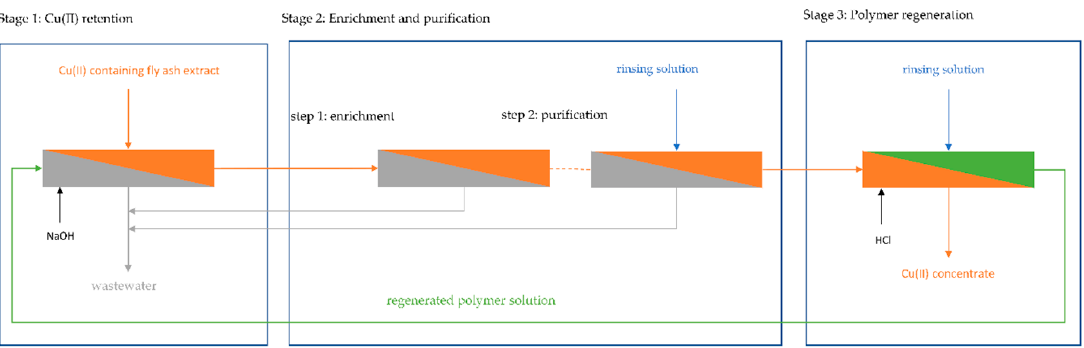
Figure 5. Multistep polymer-assisted ultrafiltration (PAUF) process for selective separation of Cu(II) from MSWI fly ash extract. A polymer-free Cu(II) concentrate is obtained in the process.